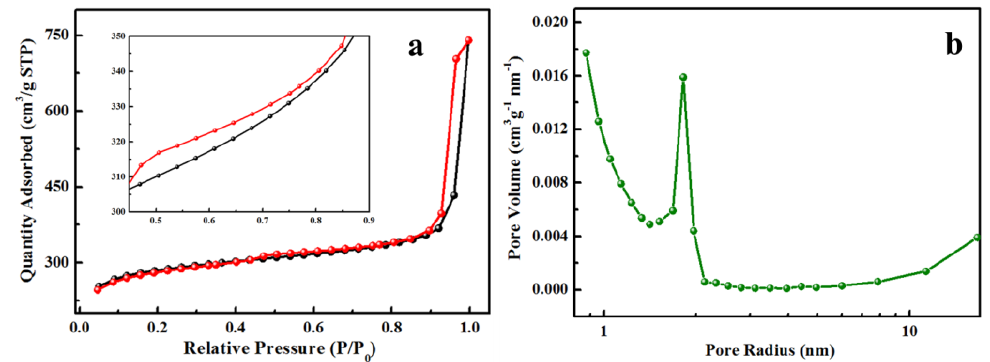
Figure 4. ( a ) N 2 sorption isotherm and ( b ) pore size distribution of the MNPC.